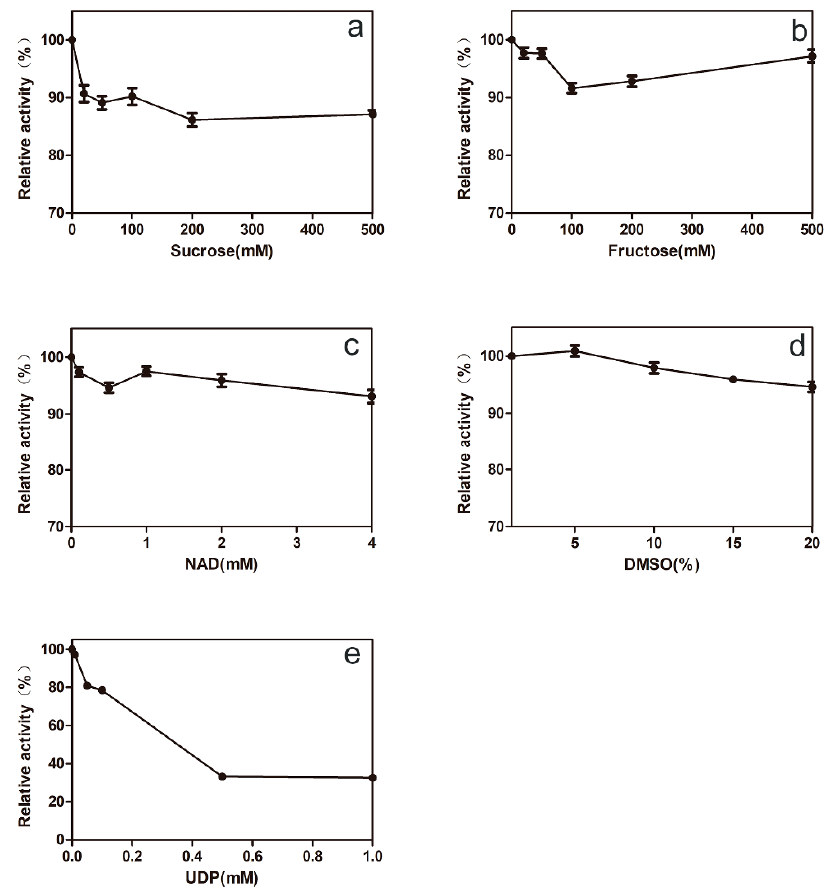
Figure 4. Effects of sucrose ( a ), fructose ( b ), NAD + ( c ), DMSO ( d ), and UDP ( e ) on the activity of purified 78D1. The initial activity was defined as 100%.